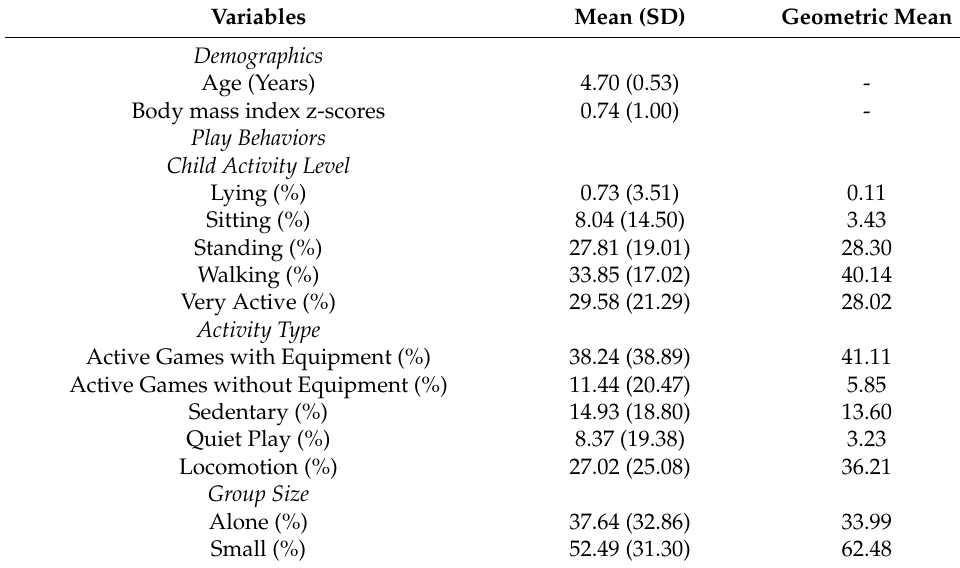
Table 1. Descriptive statistics for the final sample ( n =